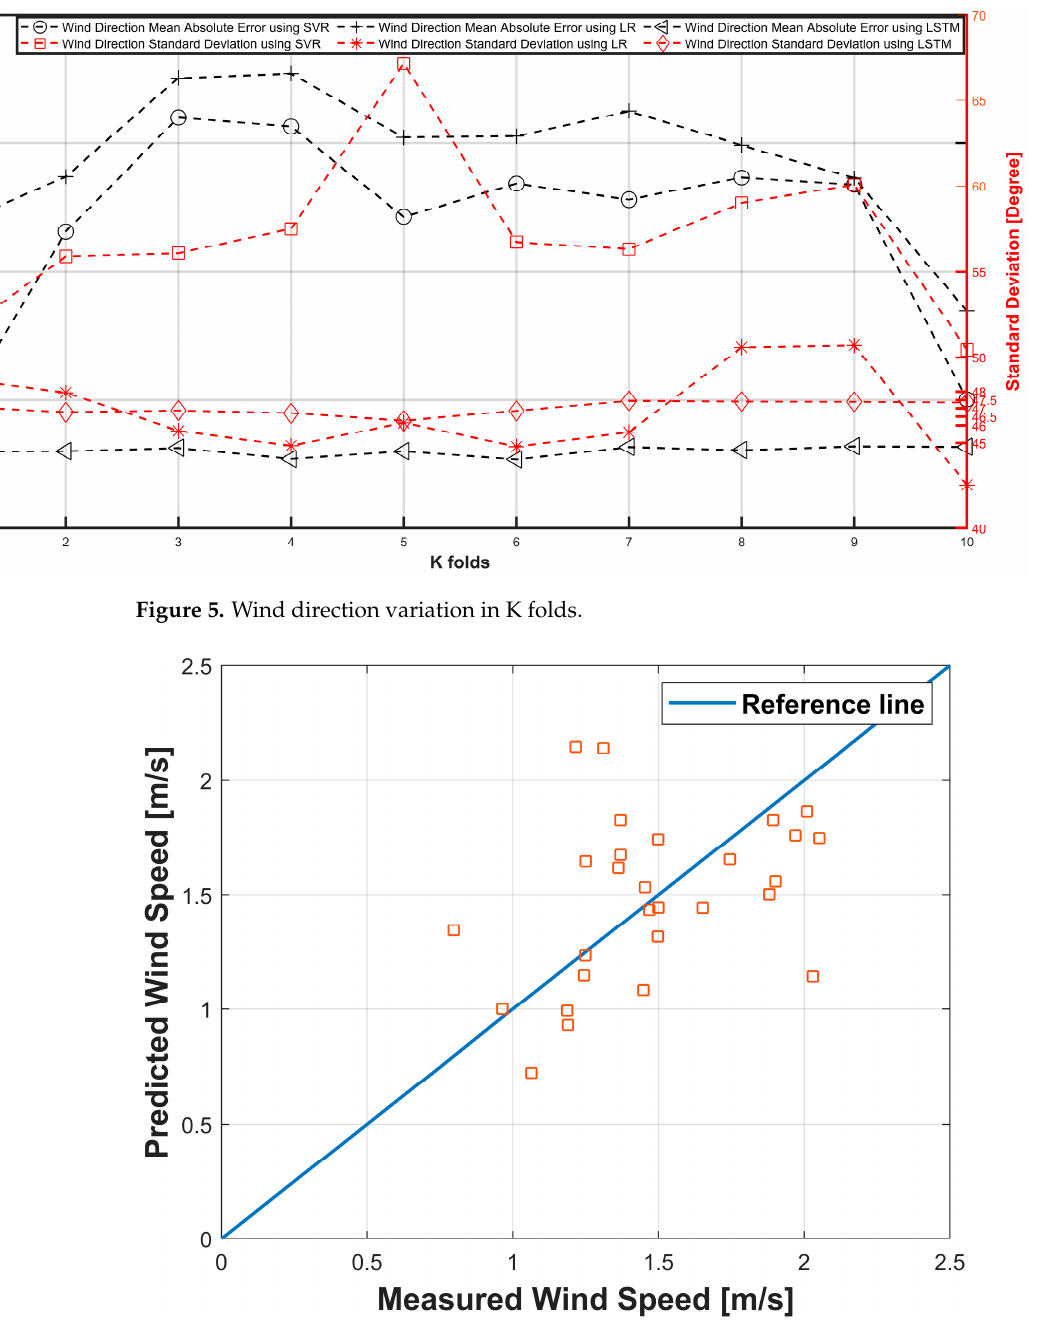
Figure 6. Accuracy of average wind speeds per day for the month of August.